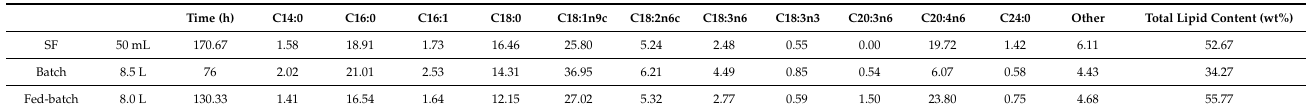
Table 2. Fatty acid composition (% wt of total lipid weight) for M. alpina single cell oil obtained from cultivation on animal fat rest